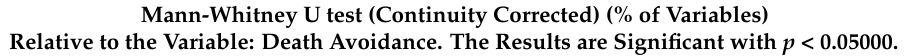
Table 5. The results of the Mann–Whitney U test for variables: AA and AE. Table 4. The results of the Mann – Whitney U test for variables: FD and AD.